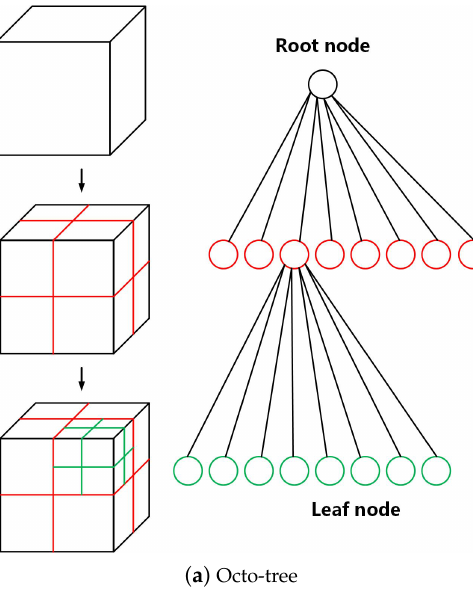
Figure 4. Explanation of the octo-tree method and its properties.( a ) Octo-tree: just as a tree root can grow leaves, a large voxel can be subdivided into multiple small voxels, and the 3D space composed of multiple voxels can also be subdivided to present more information [47]. ( b ) RGB input image: an example input image in the public dataset TUM [61]. ( c ) Sparse map: a map composed of sparse feature points in the original ORB-SLAM2 [12] as input to ( b ). Clearly, it is difficult for humans to recognize the map content. ( d ) Point cloud map: a form of dense map generated using the images in ( b ). Humans can recognize the map content, but the large storage space and inability to navigate make it unsuitable for small intelligent robots. ( e ) OctoMap: the dense map form used by our system, which is computationally economic and also efficient for navigation